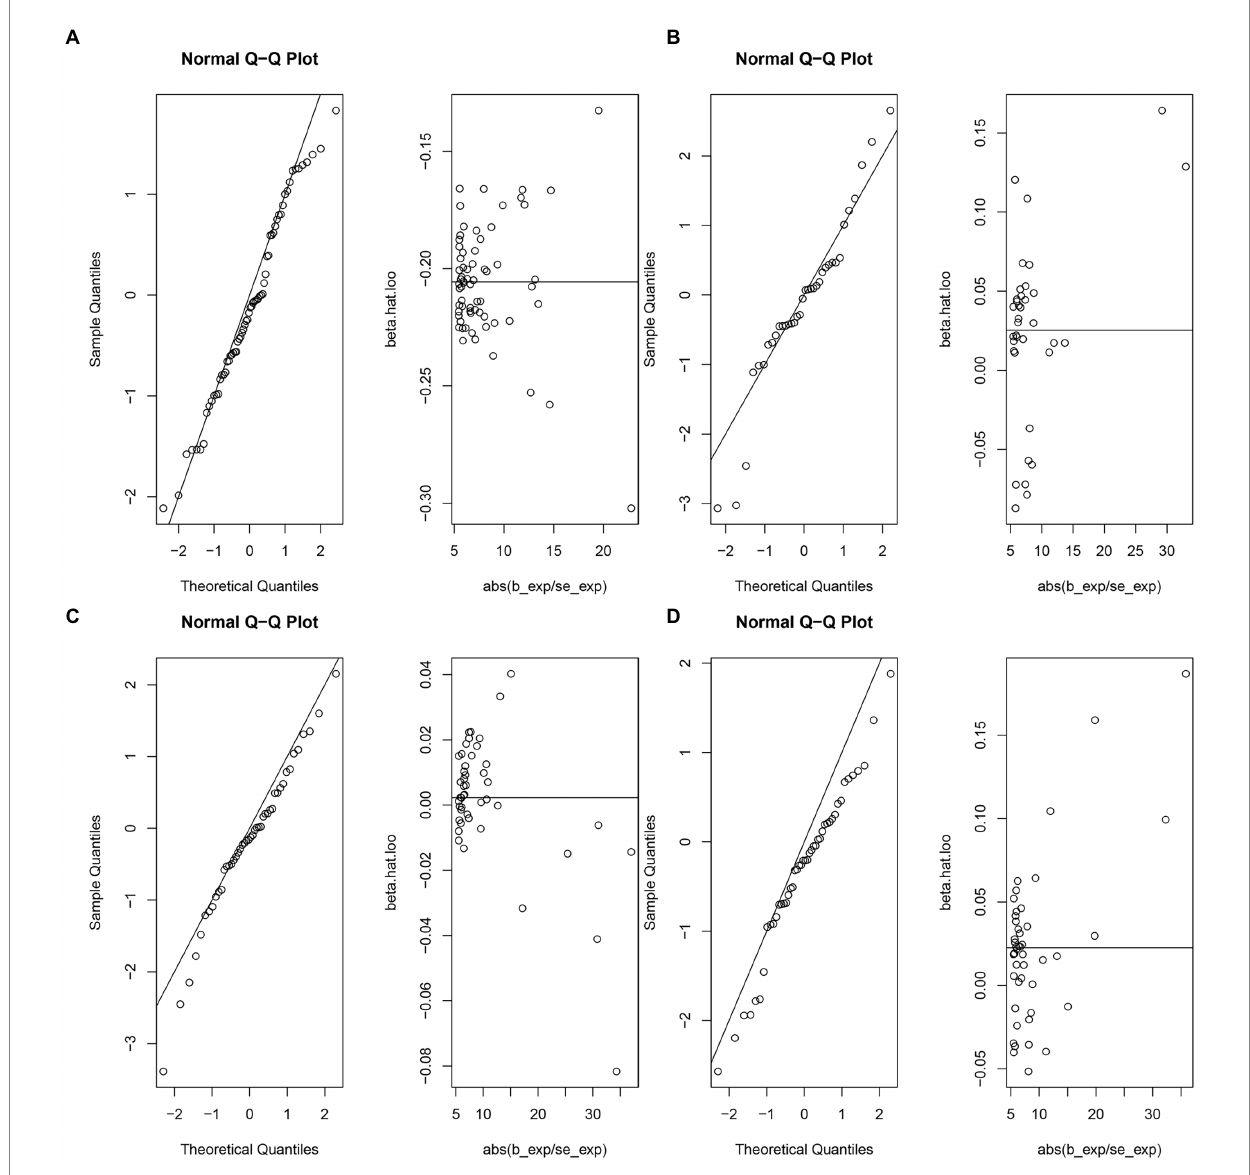
FIGURE 4 The normal distribution plots of MR analysis for exposure and outcome. (A) The normal distribution plots of MR analysis for ferritin and ankylosing spondylitis. (B) The normal distribution plots of MR analysis for serum iron and ankylosing spondylitis. (C) The normal distribution plots of MR analysis for total iron binding capacity and ankylosing spondylitis. (D) The normal distribution plots of MR analysis for transferrin saturation and ankylosing